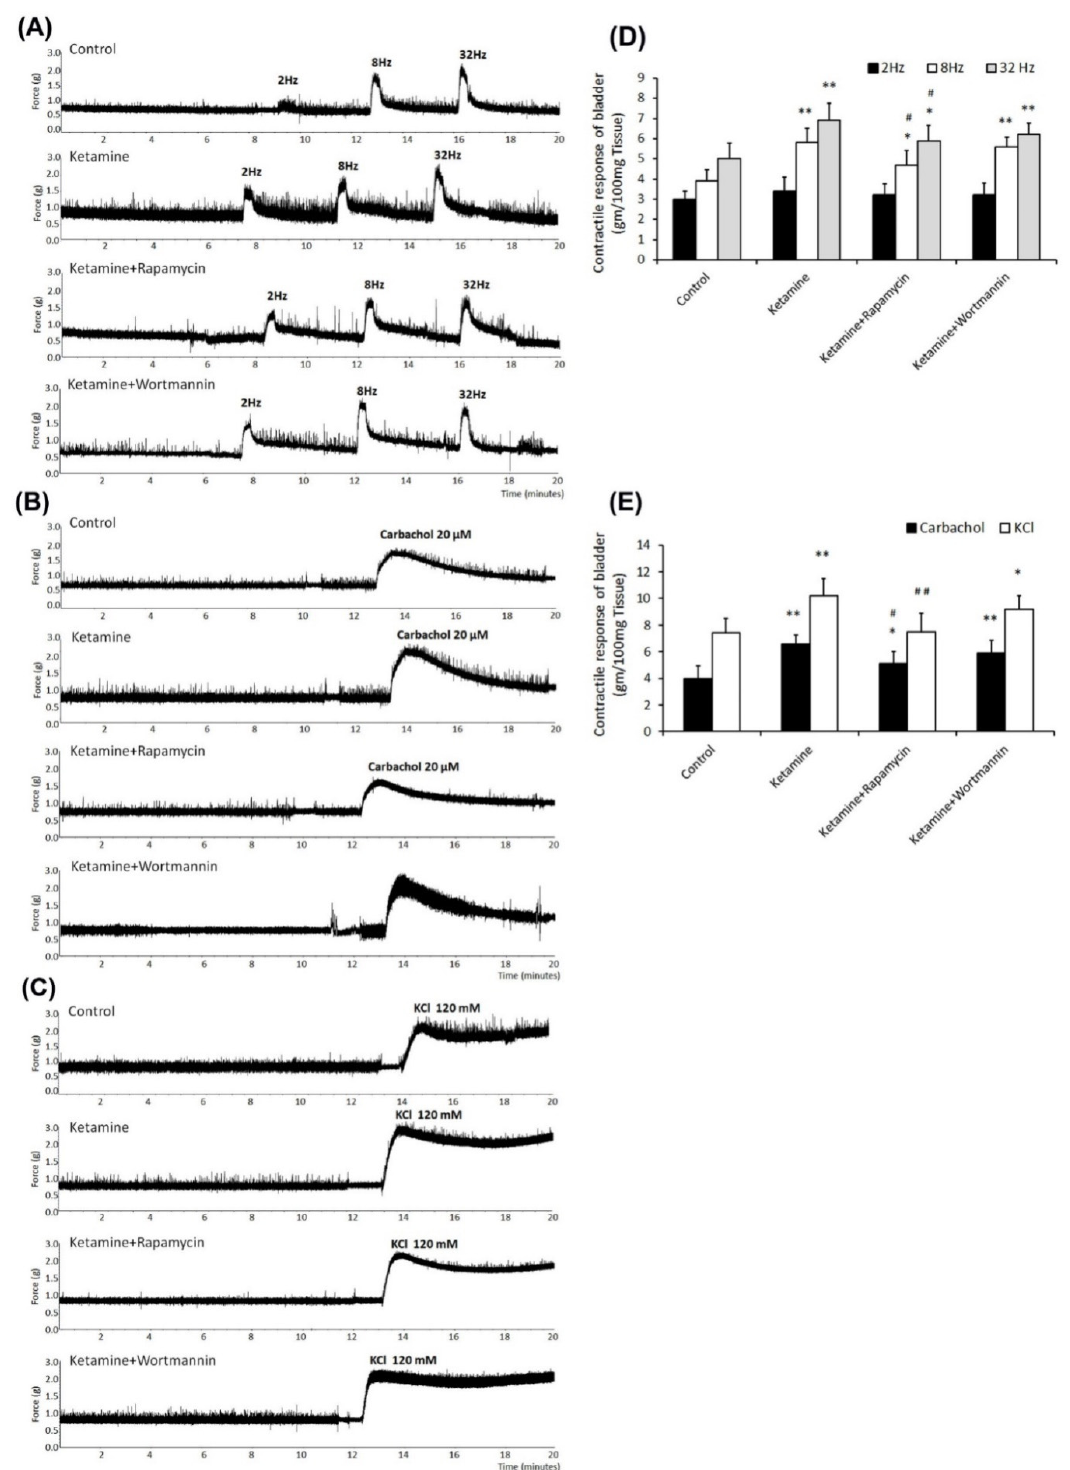
Figure 2. Contractile responses of bladder strips to electrical field, carbachol, and KCl stimulation. ( A – C ) Bladder contractile responses as examined by electrical field stimulation (2 Hz, 8 Hz, and 32 Hz) ( A ), carbachol ( B ), and KCl ( C ). ( D , E ) Statistics data of bladder contractile in responses to electrical field stimulation ( D ) or carbachol and KCl ( E ) for four different groups. The ketamine treatment caused significant contractile hyperactivity, whereas ketamine combined with rapamycin treatment improved these changes. Values are means ± SEM for n = 6. * p < 0.05 and ** p < 0.01 vs. the control group. # p < 0.05 and ## p < 0.01 vs. the ketamine group.